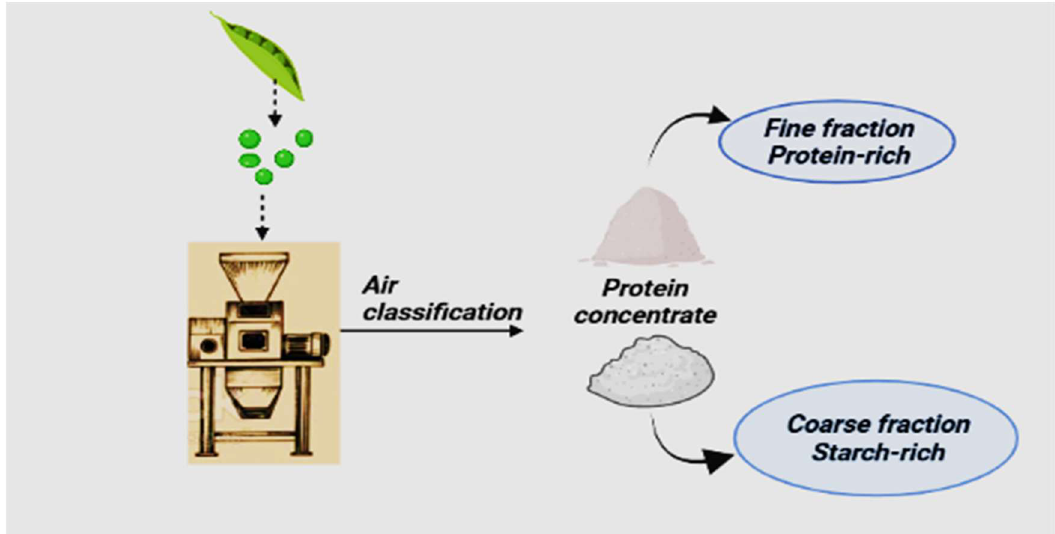
Figure 2. Extraction of pea protein concentrate by dry fractionation method.